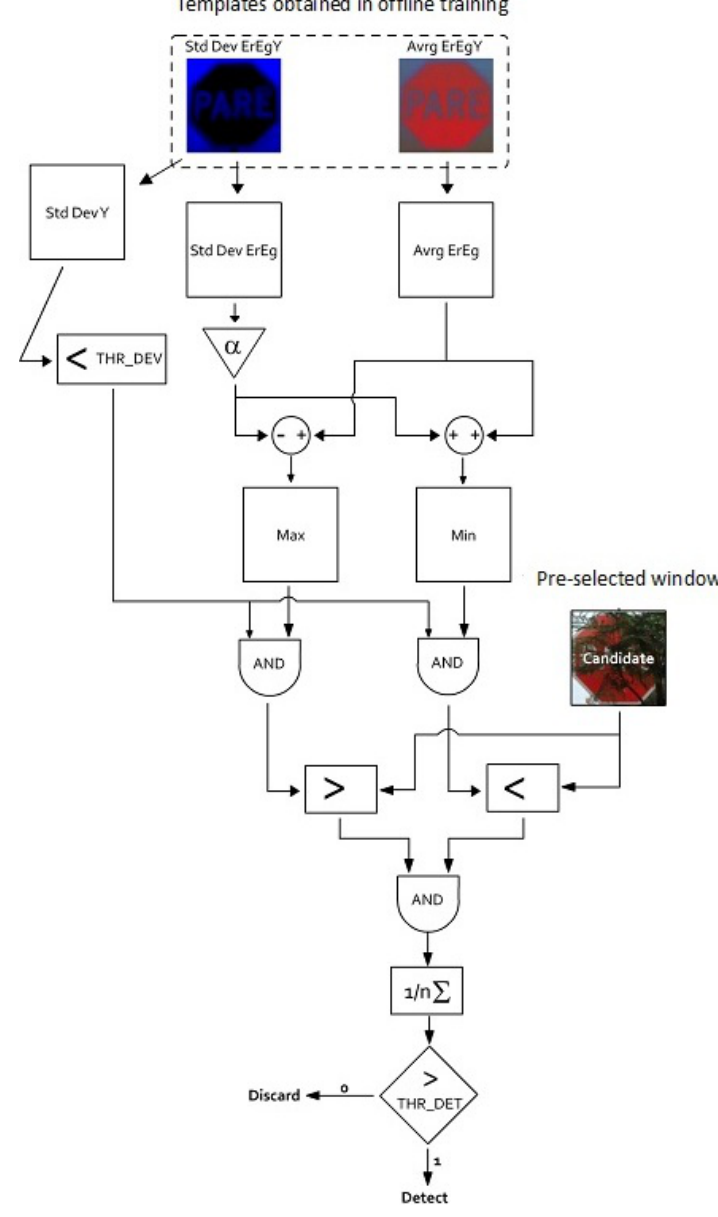
Figure 5. Flow chart of the recognition stage based on statistical